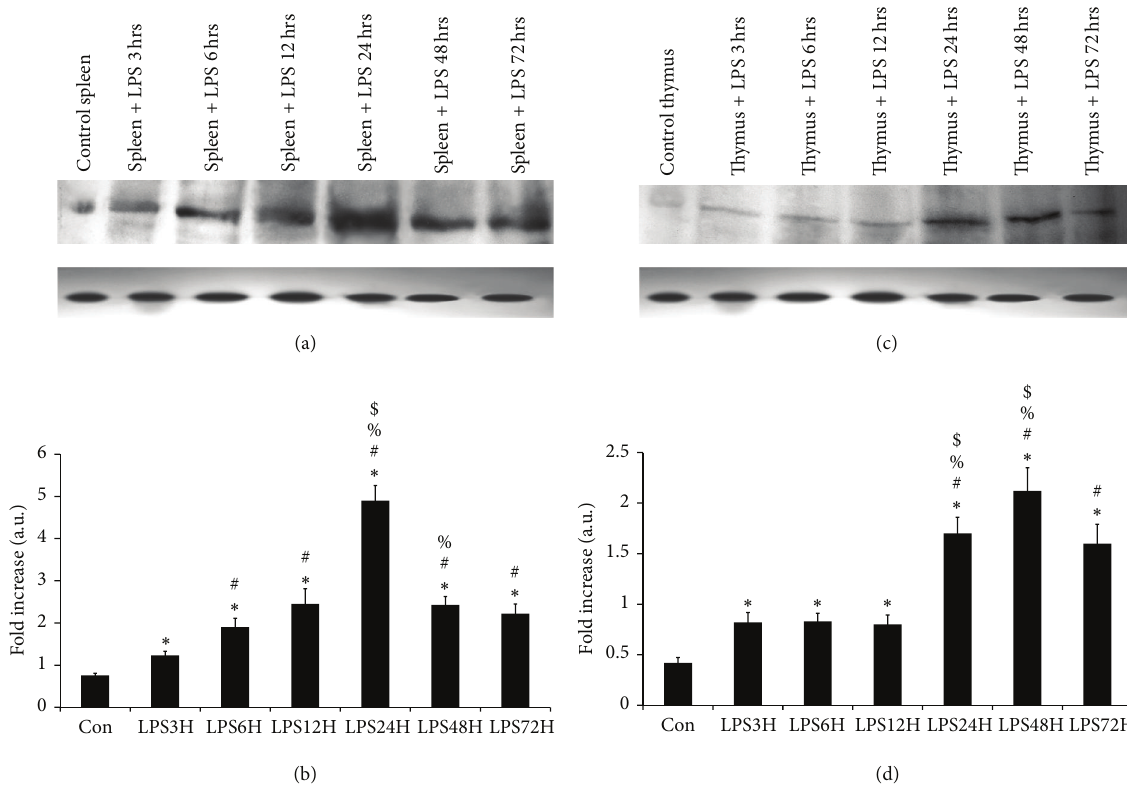
Figure 2: Expression of TLR-4 receptor protein in the spleen and thymus. The results in Figures (a) and (c) represent the differential translation of the TLR-4 mRNA to the protein in the spleen and thymus, respectively, in mice with experimental endotoxemia from triplicate experiments. Lane 1 (Con) represents TLR-4 in tissues from control mice, lane 2 (LPS3H) from LPS treated mice at 3 hours after treatment, lane 3 (LPS6H) from LPS treated mice at 6 hours after treatment, lane 4 (LPS12H) from LPS treated mice at 12 hours after treatment, lane 5 (LPS24H) from LPS treated mice at 24 hours after treatment, lane 6 (LPS48H) from LPS treated mice at 48 hours after treatment, and lane 7 (LPS72H) from LPS treated mice at 72 hours after treatment. Results in (b) and (d) is the diagrammatic representation of the fold difference in their expression after LPS treatment compared to control and among different time periods of treatment as seen in (a) and (c), respectively. The approximate band size is about 95 KD. The following symbols indicates the significant change in the expression of TLR-4 between: ∗ control versus LPS treated tissues, # LPS treatment for 3 hours versus LPS treatment for 6, 12, 24, 48, and 72 hours, % LPS treatment for 6 hours versus LPS treatment for 12, 24, 48, and 72 hours, $ LPS treatment for 12 hours versus LPS treatment for 24, 48, and 72 hours. Significant change ( 𝑃 < 0.05